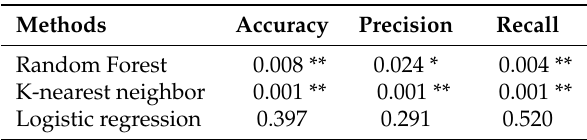
Table 6. Student t-test results which compare the classification performance of SVM with random forest, KNN and logistic